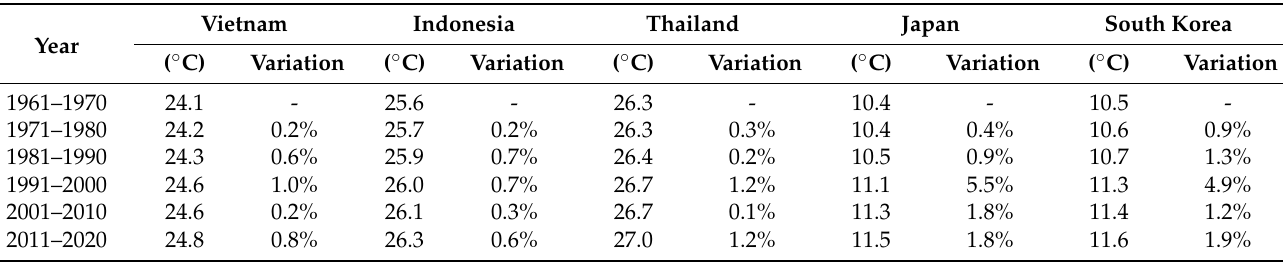
Figure 13. Average annual mean temperature anomalies in ( a ) Vietnam, ( b ) Indonesia, ( c ) Thailand, ( d ) Japan, and ( e ) South Korea. These data range from 1961 to 2020. (Source: data retrieved from [4,84]). Table 13. The 10-year average of annual mean temperature and variations between each decade in Vietnam, Indonesia, Thailand, Japan, and South Korea from 1961 to 2020. (Source: data retrieved from [4,84]).